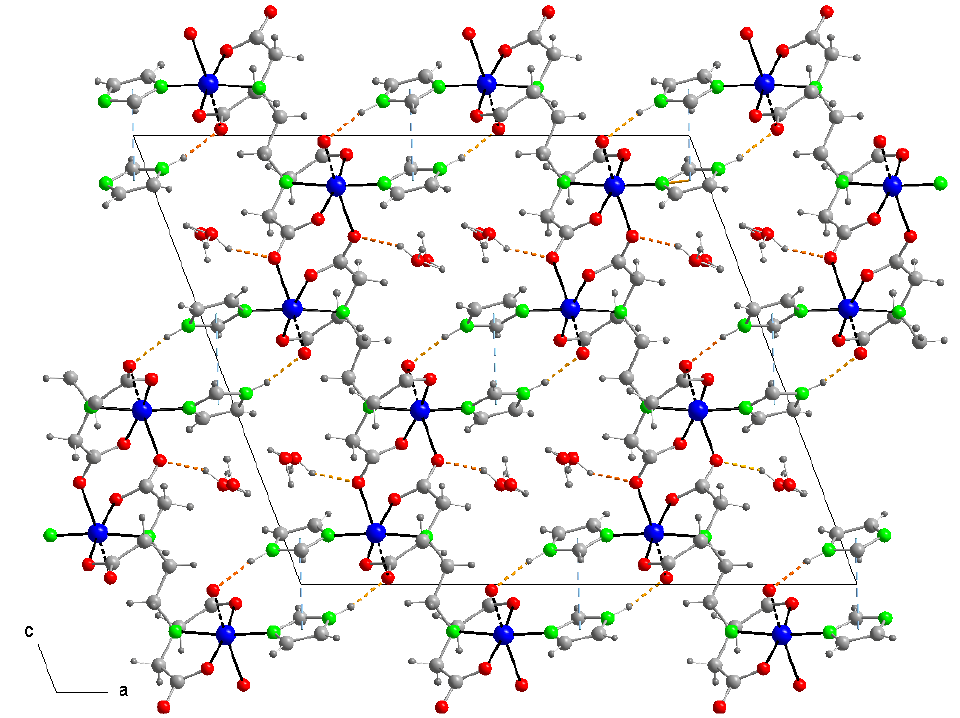
Figure 5. Intermolecular interactions contributing to the stability of the crystal of 1 , uniting the association of the 2D layered coordination polymer (N-H···O, π –staking) and reinforcing the retention of half the water (cooperation of O-H···O, O-H/ π ).